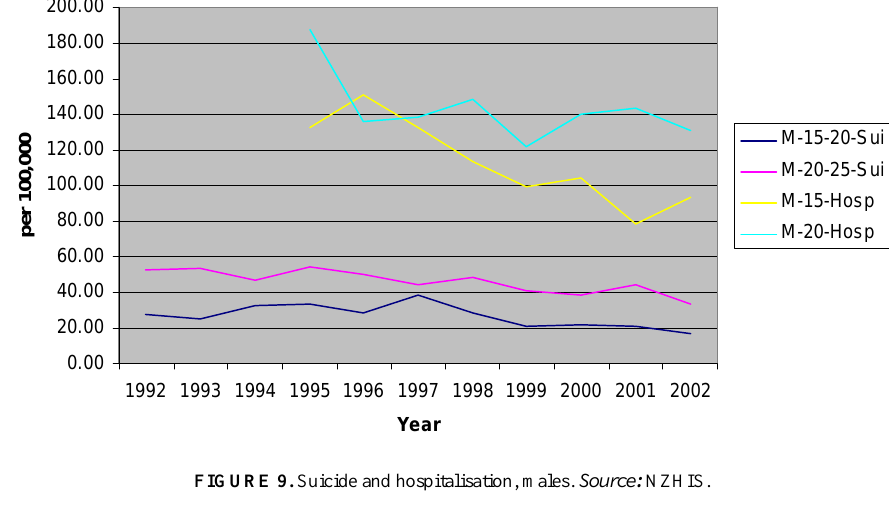
FIGURE 9. Suicide and hospitalisation, males. Source: NZHIS.